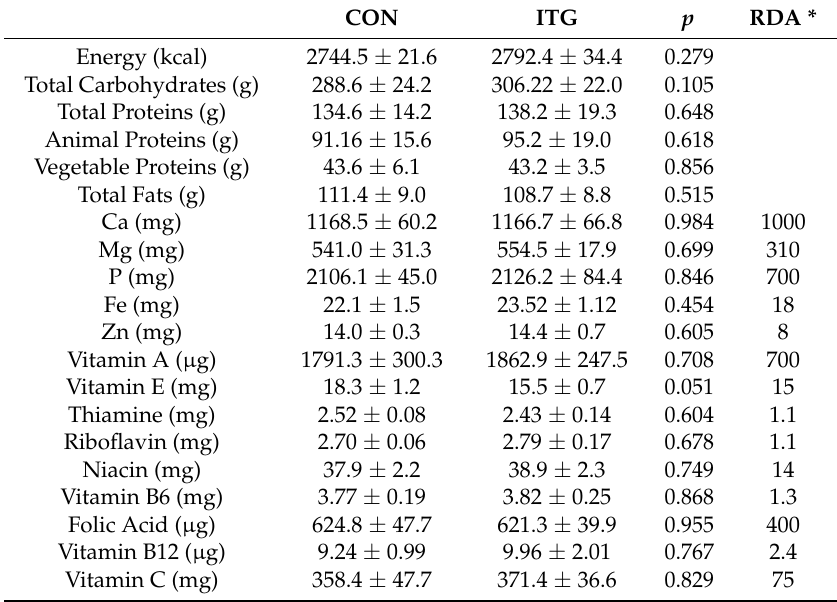
Table 3. Energy, macro and micronutrients intake in control group (CG) and iron treatment group (ITG) during follow up